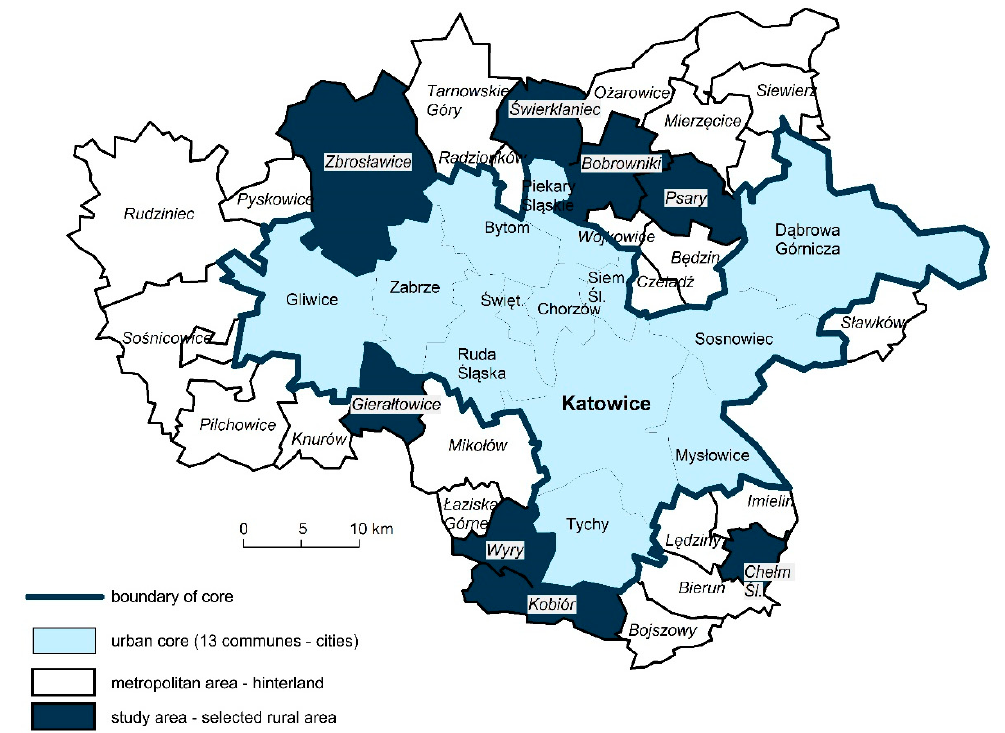
Figure 1. Study area with the selected rural communes in the hinterland of the Górno ś l ą sko-Zag łę biowska Metropolis (GZM). Table 1. Population and area of the GZM in